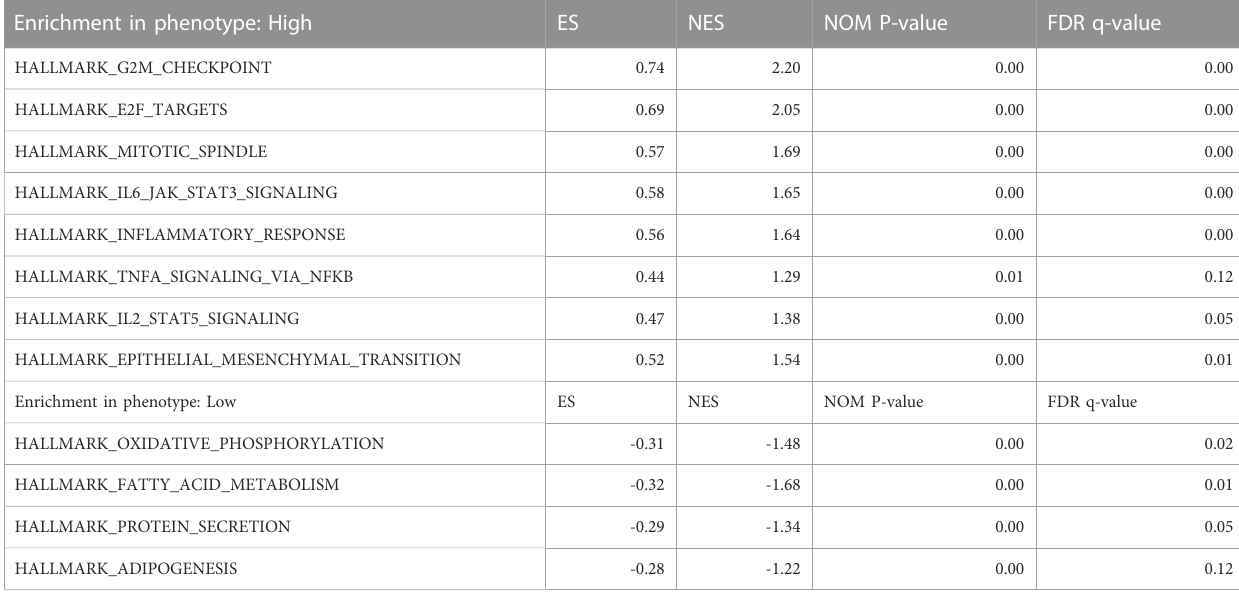
TABLE 3 The enrichment of GSEA gene sets at both the NOM P-value < 0.05 and FDR q-value < 0.25. Enrichment in phenotype: